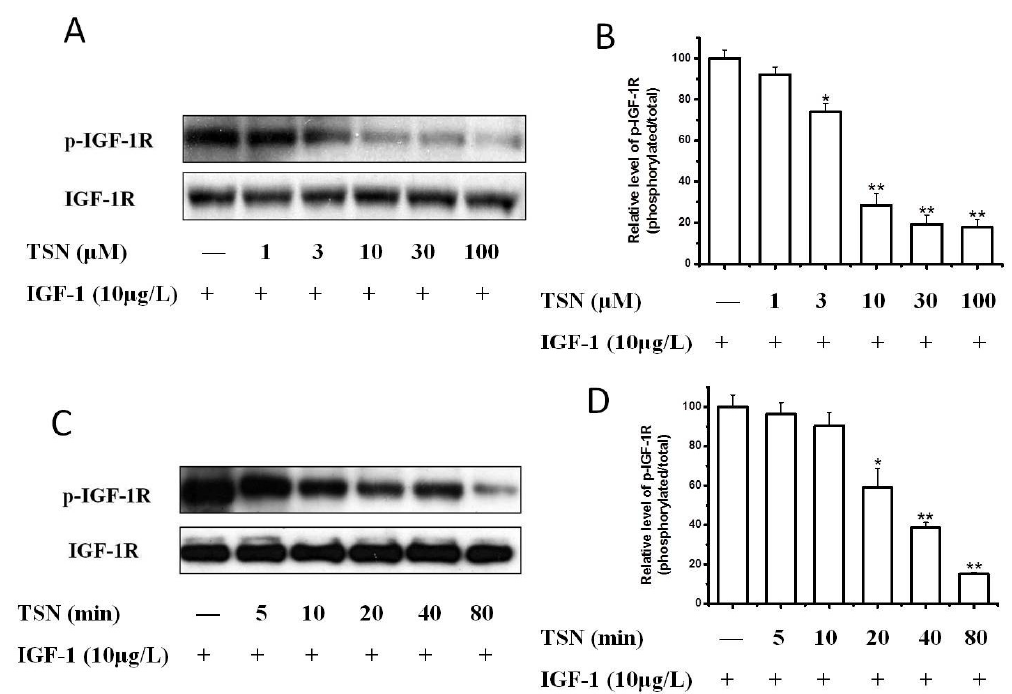
Figure 4. TSN attenuated IGF-1R activation induced by IGF-1 in PC12 cells. ( A ) PC12 cells were treated with various concentrations of TSN and 10 µ g/L IGF-1. The levels of p-IGF-1R were determined by Western blotting; ( B ) The ratio of p-IGF-1R/IGF-1R in PC12 cells after treatment with various concentration of TSN and 10 µ g/L IGF-1; ( C ) PC12 cells were treated with 20 µ M TSN and 10 µ g/L IGF-1 at various time points. The levels of p-IGF-1R were determined by Western blotting; ( D ) Relative levels of p-IGF-1/IGF-1R in PC12 cells treated with 20 µ M TSN and 10 µ g/L IGF-1 at various time points were determined by densitometry of the blots and densitometric analysis of the immunoblot was expressed as a percentage of control. The results are displayed as the mean ± SEM and represent three independent experiments, * p < 0.05, ** p < 0.01 versus control.